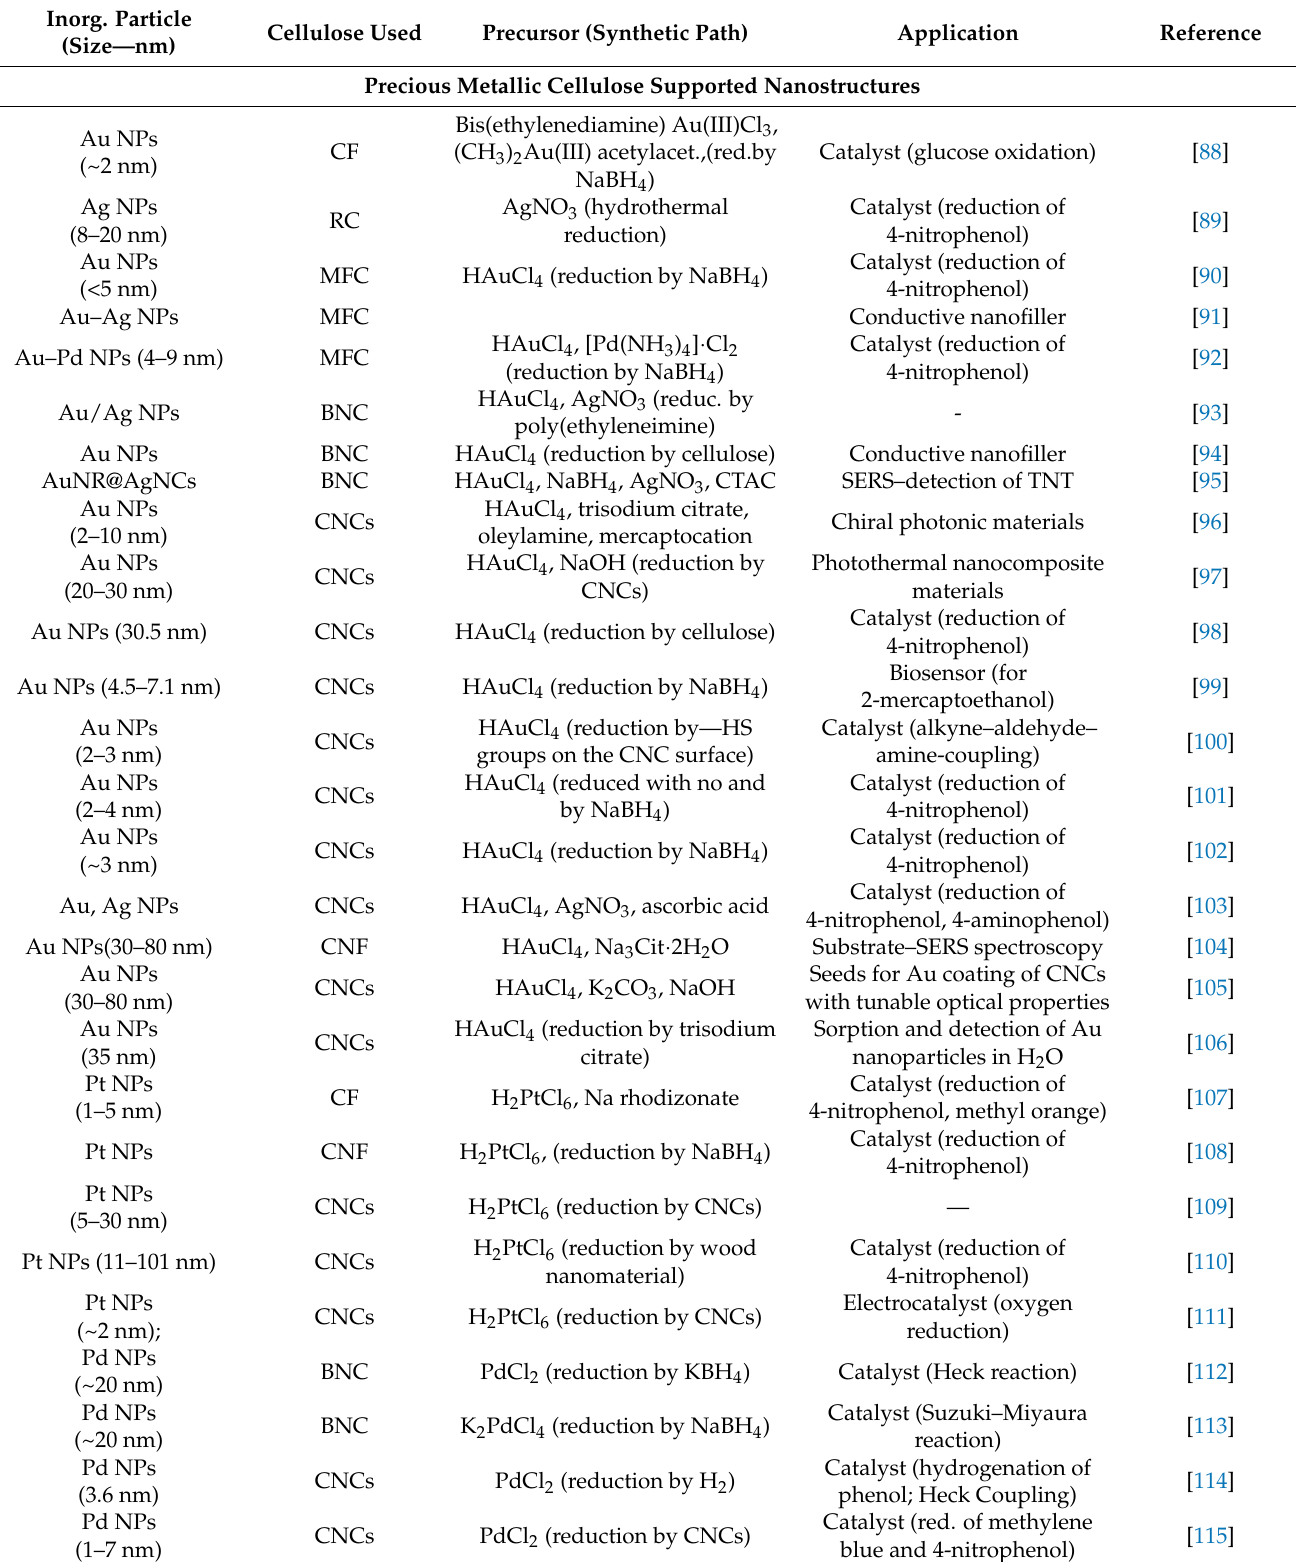
Table 1. The list of publications on cellulose supported metallic nanostructures. The list is organized from large cellulose structures (CF and RC) via microstructured celluloses (MCC and MFC) to nanostructured celluloses (BNC and